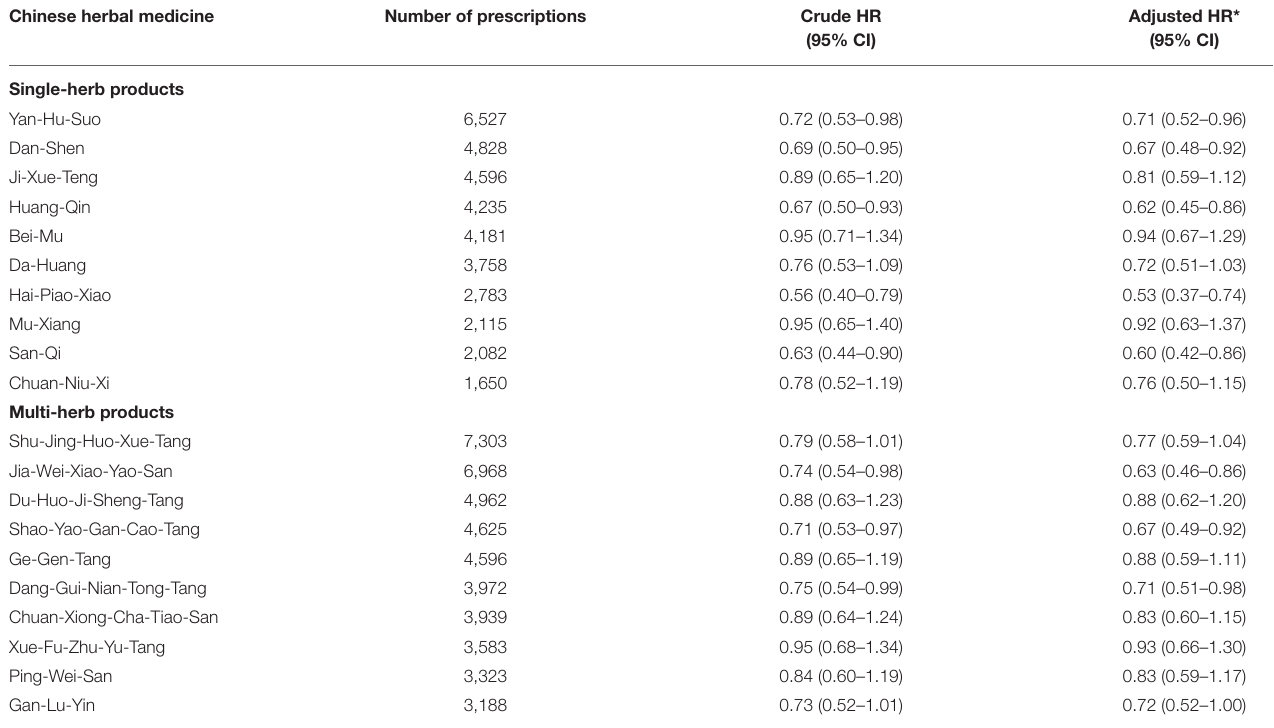
TABLE 4 | Risk of HL associated with use of the 10 most-used single-herb and multi-herb CHM products for RA patients. Chinese herbal